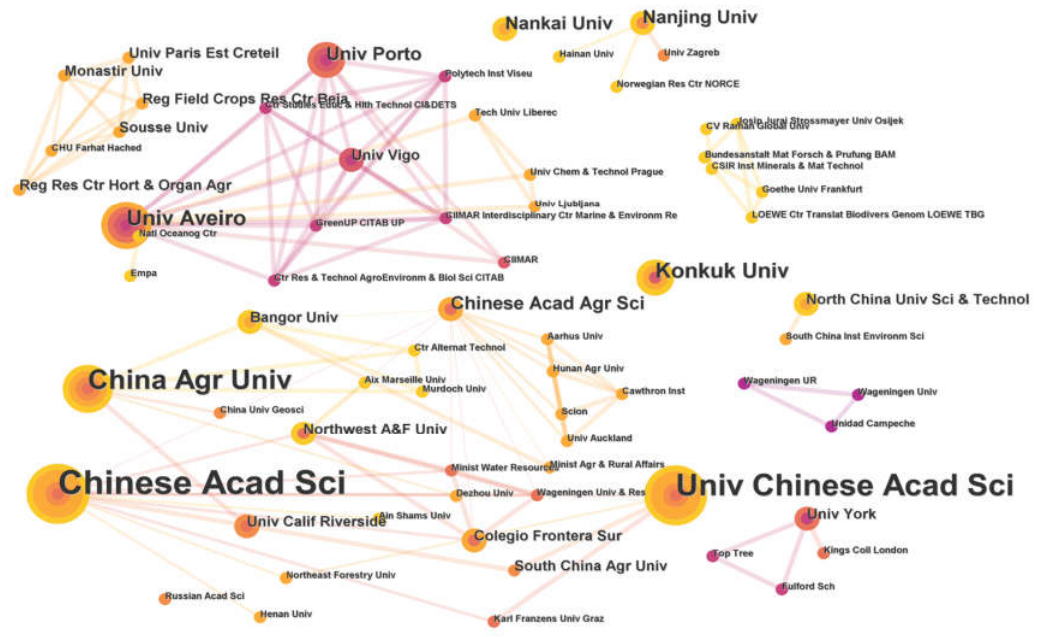
Figure 5. Institution cooperation network in the field of micro(nano)plastic toxicity to earthworms.